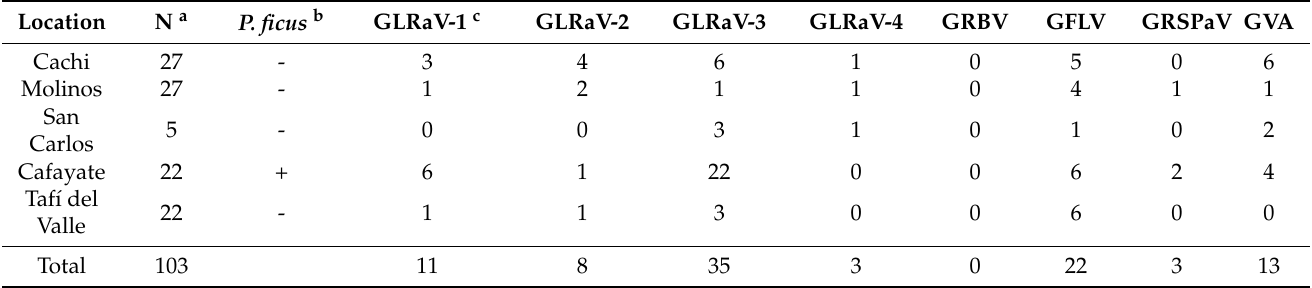
Table 1. Number of positive samples detected for each grapevine virus analyzed by